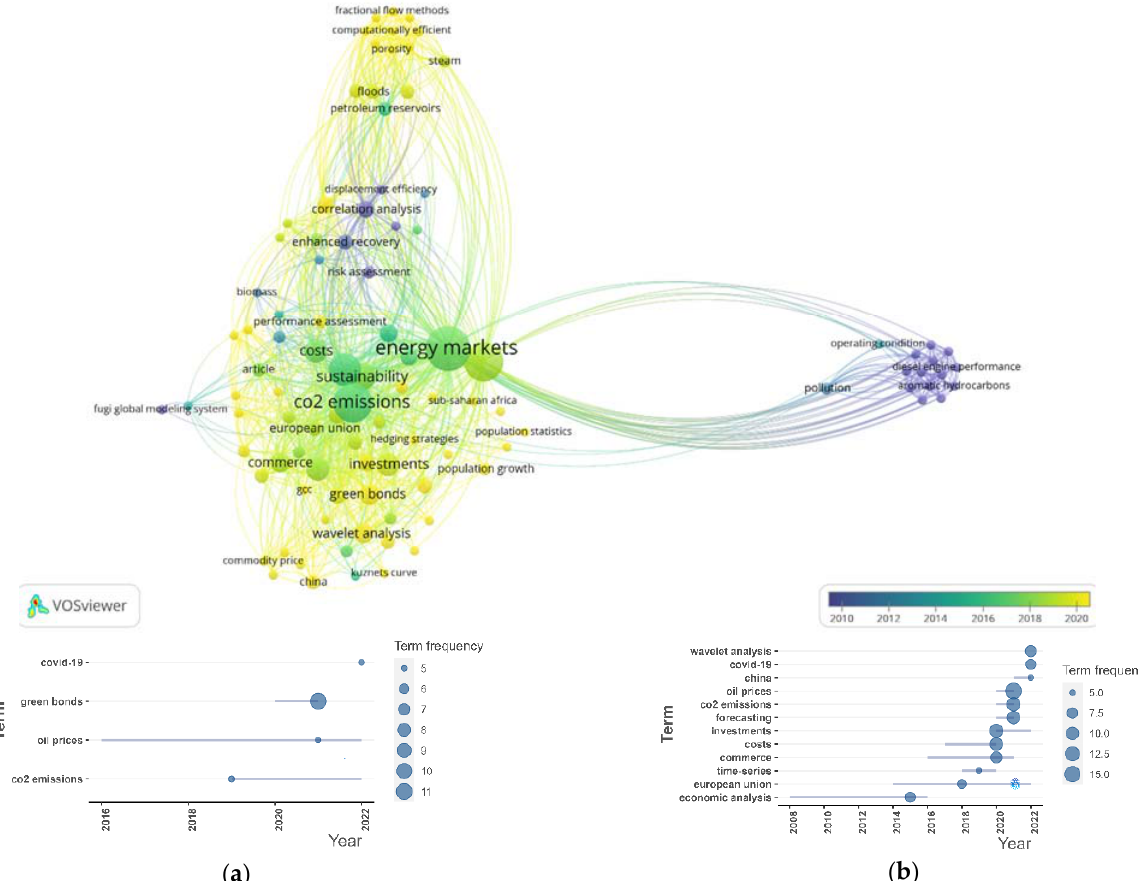
Figure 3. Main keyword trends identified in the research topic are dynamic linkages among oil prices, green bonds, and CO 2 emissions. Source: Authors’ research using VOSviewer, Bibliometrix tools, Scopus, and WoS databases. ( a ) Author’s keywords trend topics; ( b ) Keywords plus trend topics.